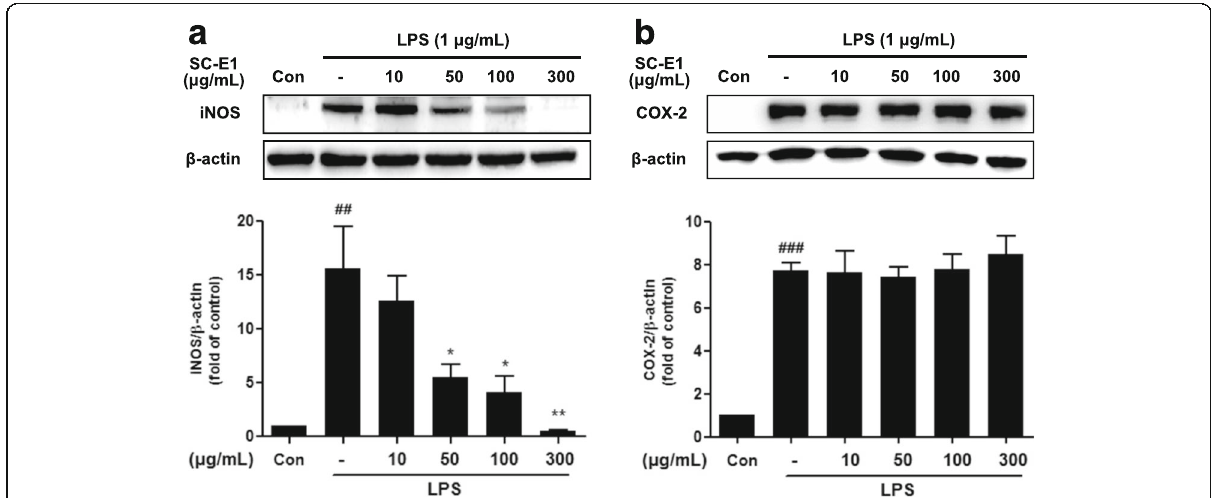
Fig. 4 Effects of SC-E1 on the expression of iNOS and COX-2 in LPS-stimulated RAW 264.7 macrophages. Western blotting showed that the protein levels of iNOS ( a ) and COX-2 ( b ) were considerably higher in the LPS-treated RAW 264.7 macrophages than in the controls. SC-E1 pretreatment reduced the LPS-induced increases in iNOS protein levels. β -actin was used as an internal control. Each experiment conducted for 3 repeats per conditions. (Significant compared to the control, ## p < 0.01 and ### p < 0.001, significant compared to LPS alone, * p < 0.05 and ** p <